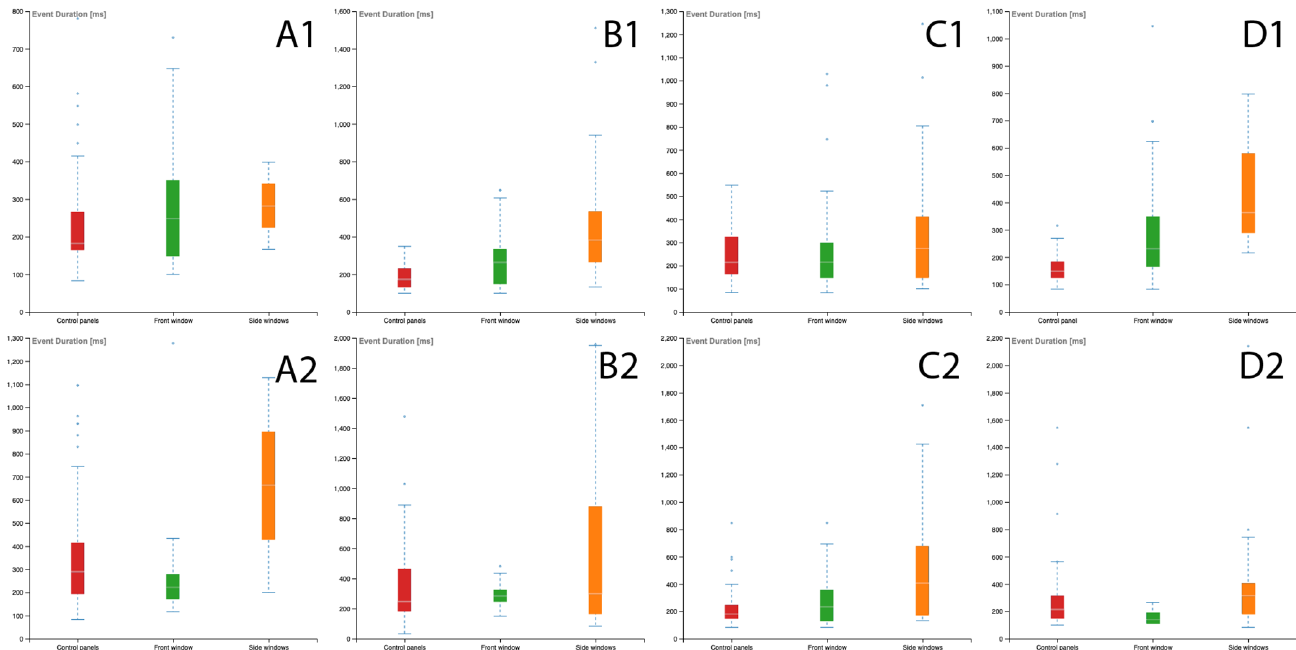
Figure 12. Analysis of the length of fixations at the AOI during the arrival and departure of the train from the station or from the railway stop.